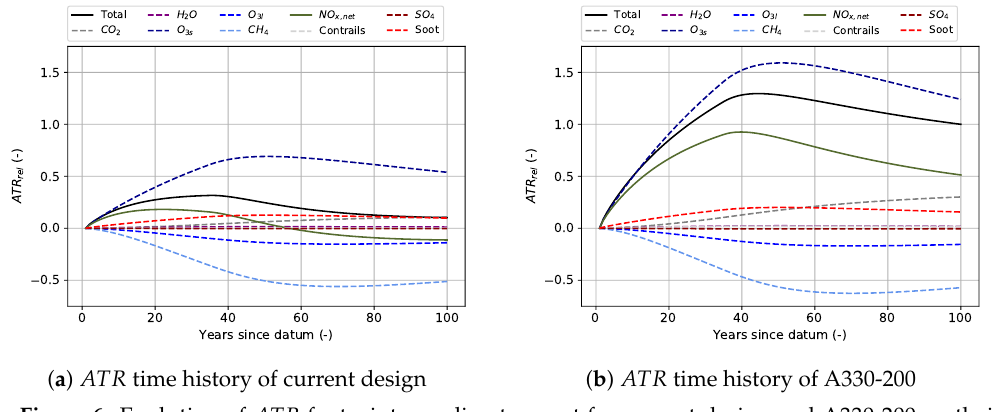
Figure 6. Evolution of ATR footprint per climate agent for current design and A330-200 on their respective reference